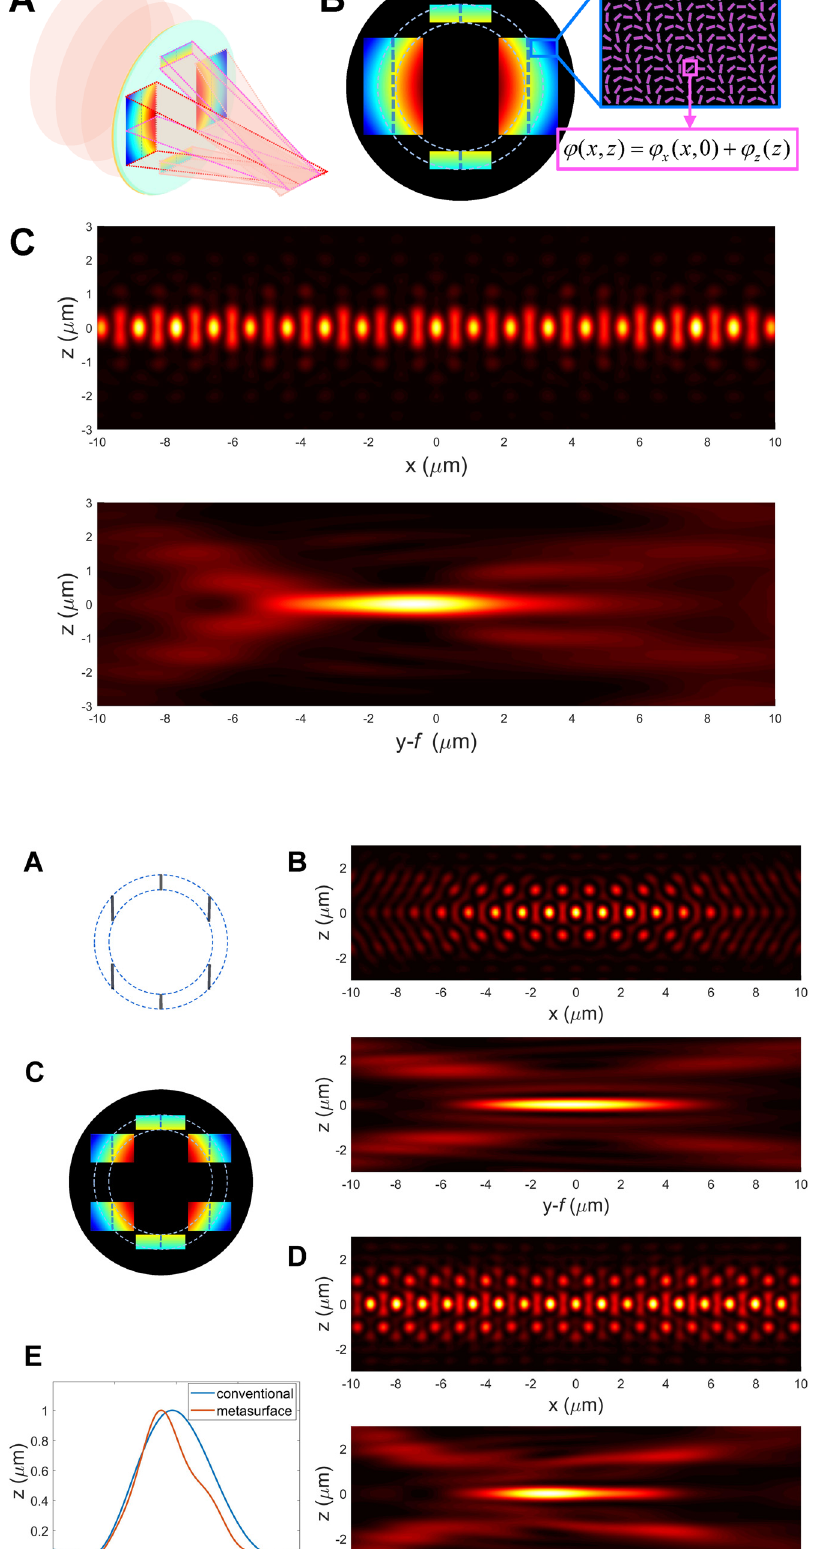
Figure 5: (A) Pupil function for the generation of hexagonal lattice light-sheet by the conventional LLSM, and the corresponding xz and yz cross-sectional intensity distribution is shown in (B). (C) Metasurface design with the same parameters used in Figure 4 except that NA side = 0.49, and (D) the corresponding simulated xz and yz cross-sectional intensity distribution of the metasurface- basedhexagonallatticelight-sheet.(E)The intensity pro fi les along y at z = 0 extracted from the yz cross-sectional intensity distributions in (B) and (D).